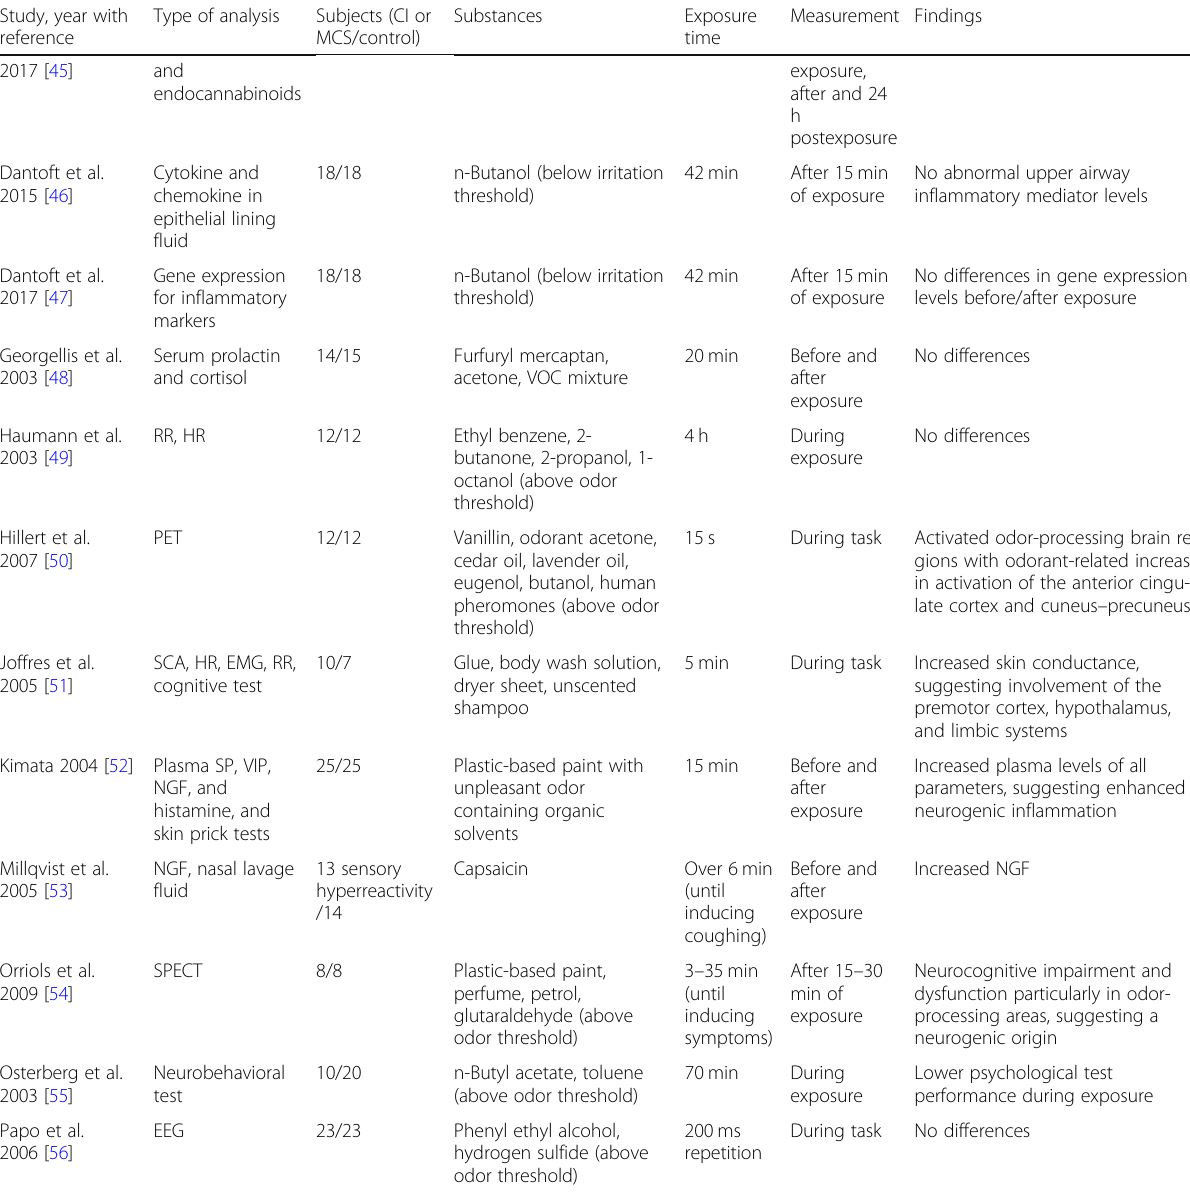
Table 1 Summary of experimental human studies associated with CI and related neurological responses or brain imaging in chemical provocation tests